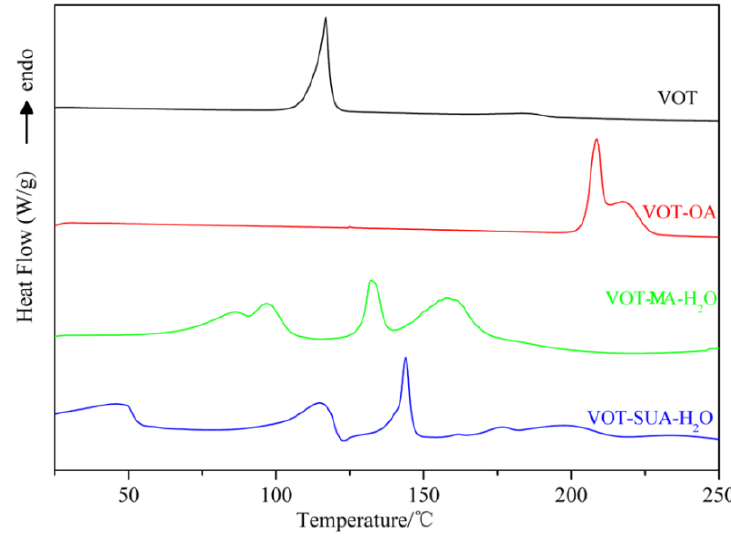
Figure 7. DSC thermograms of VOT, VOT-OA, VOT-MA-H 2 O, and VOT-SUA-H 2 O salt.